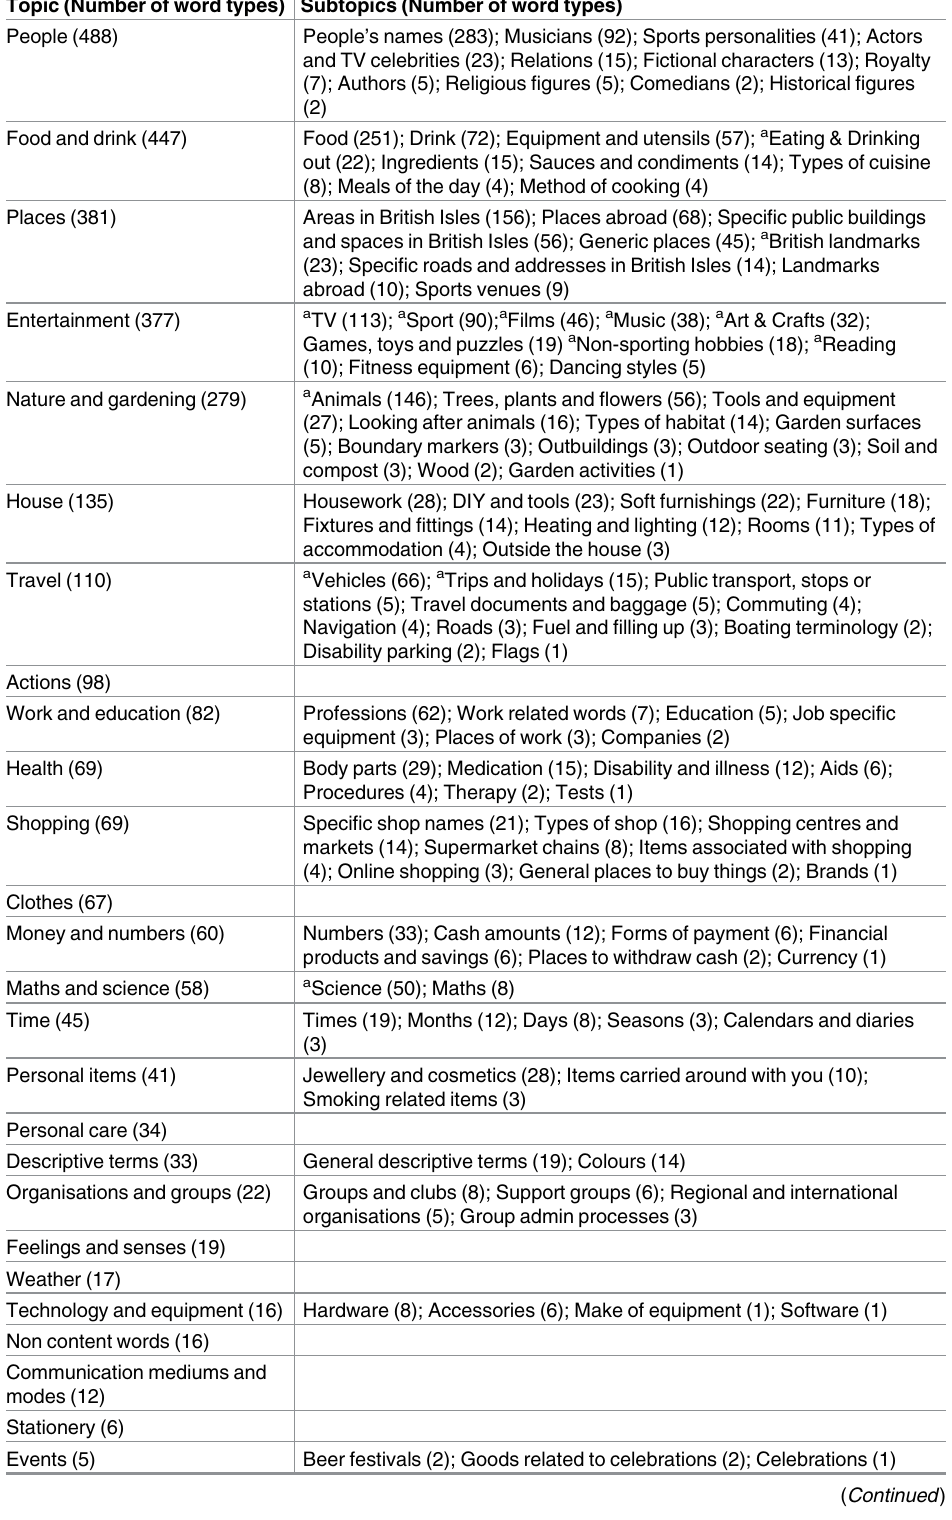
Table 2. Topics and subtopics of words selected for practice by people with